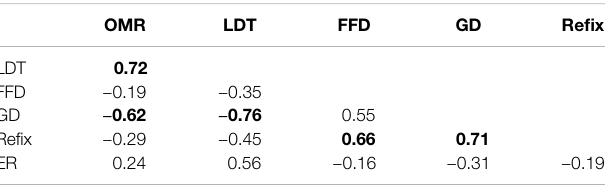
TABLE 3 | Correlation matrix for the different dependent measures (OMR – One Minute Reading speed; LDT – Lexical Decision reading speed (wpm); FFD – fi